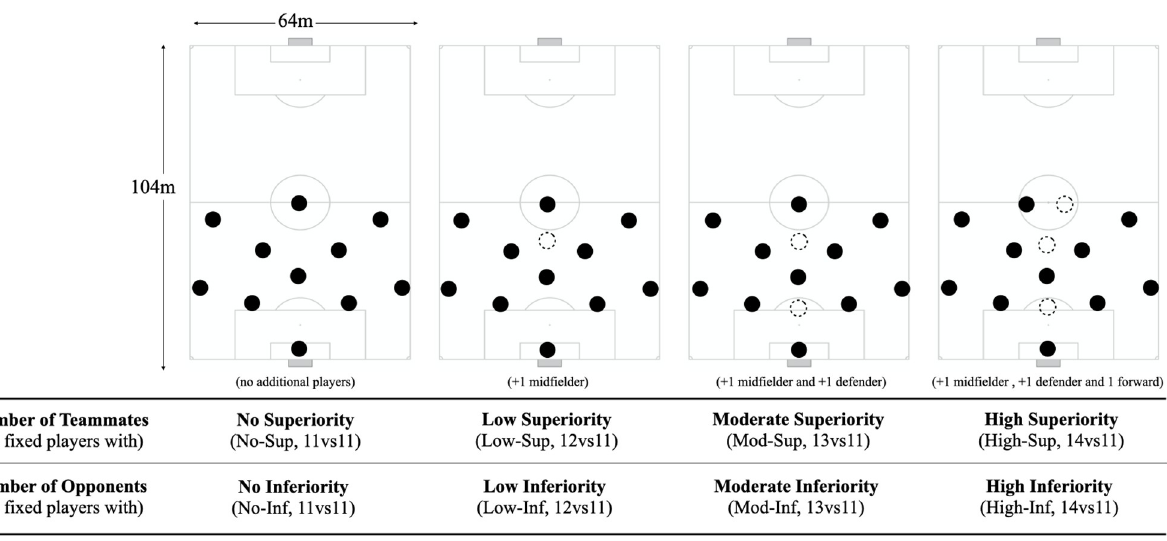
Fig 1. Representation of LSG